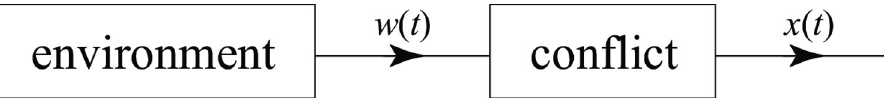
Fig 20. The modified model when an exogenous stress w ( t ) is influencing the